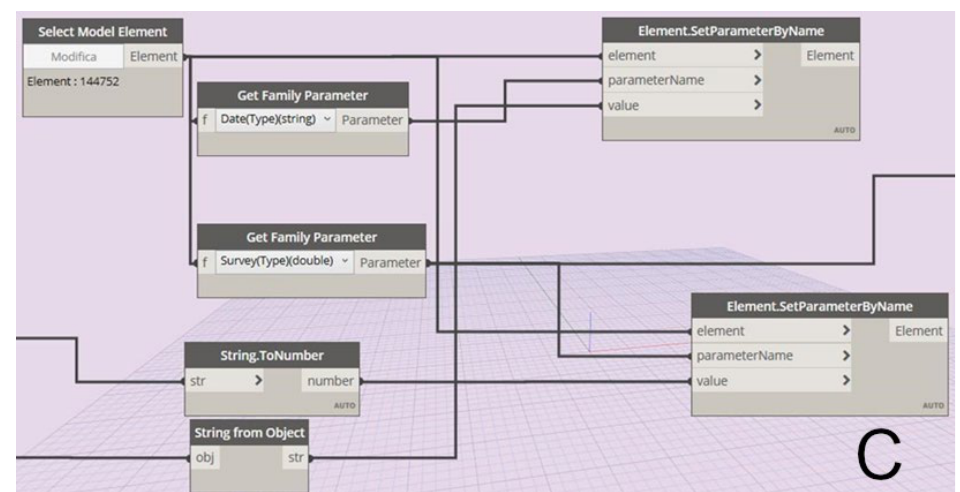
Figure 5. MySQL ODBC connection nodes.